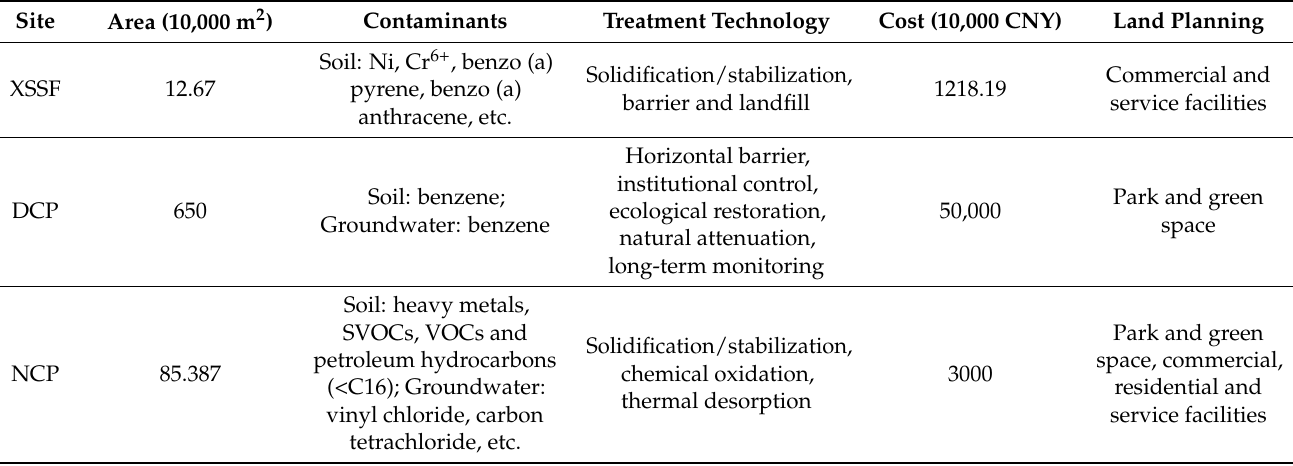
Table 1. Basic information of the studied